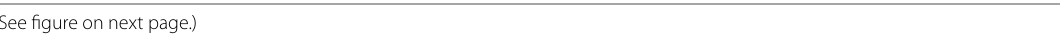
figure on next Fig. 6 Poor pavement condition through multiple sensors in two road sections. a Poor pavement condition through multiple sensors (road Sect. 1). b Poor pavement condition through multiple sensors (road Sect. 2). Note: the selected significant points in the circle are validated through recorded video. c The significant points correspond to the road condition in road Sect. 2. Source: https:// cdn. arcgis. com/ shari ng/ rest/ conte nt/ items/ 0df19 d2d94 0b476 58857 cc2fc 96238 40/ resou rces/ styles/ root.